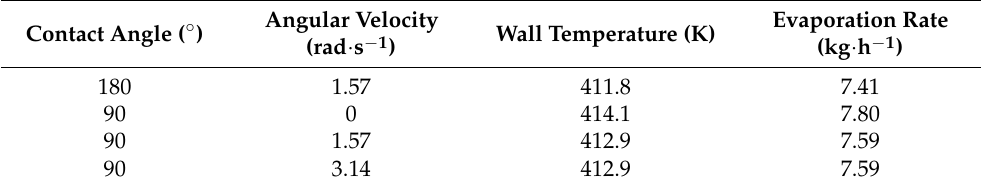
Table 6. Comparison of the equivalent evaporation rates in dropwise condensation at different ro- tational angular velocities.